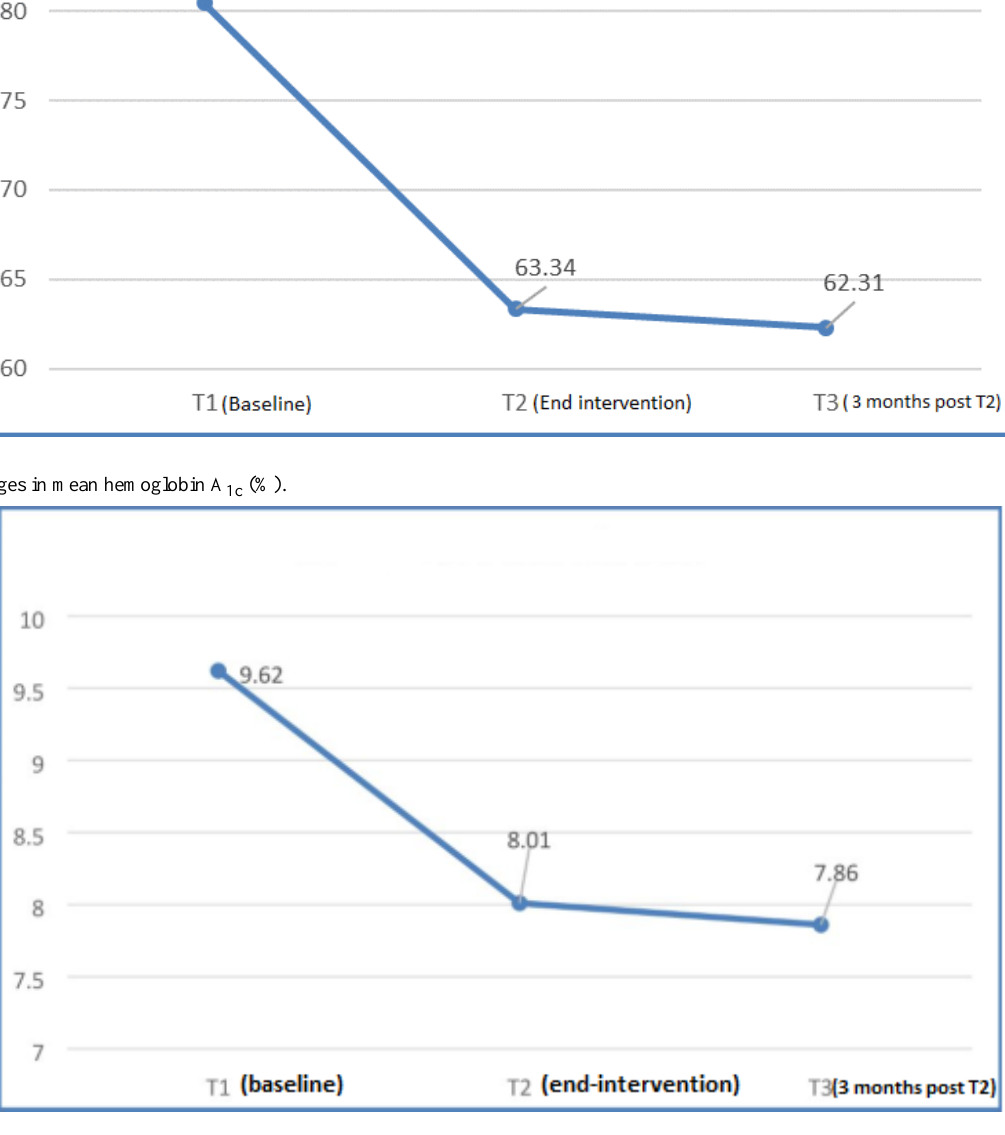
Table 2. Change in weight and BMI among participants (N=39).